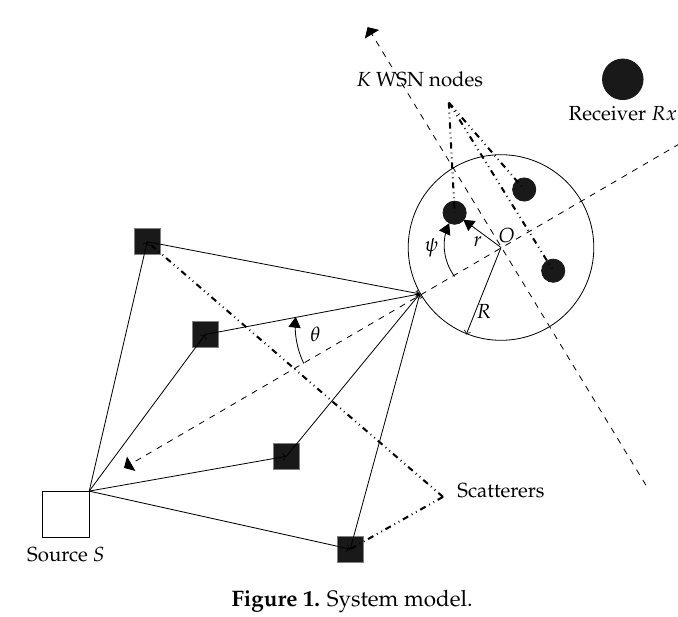
Figure 1. System